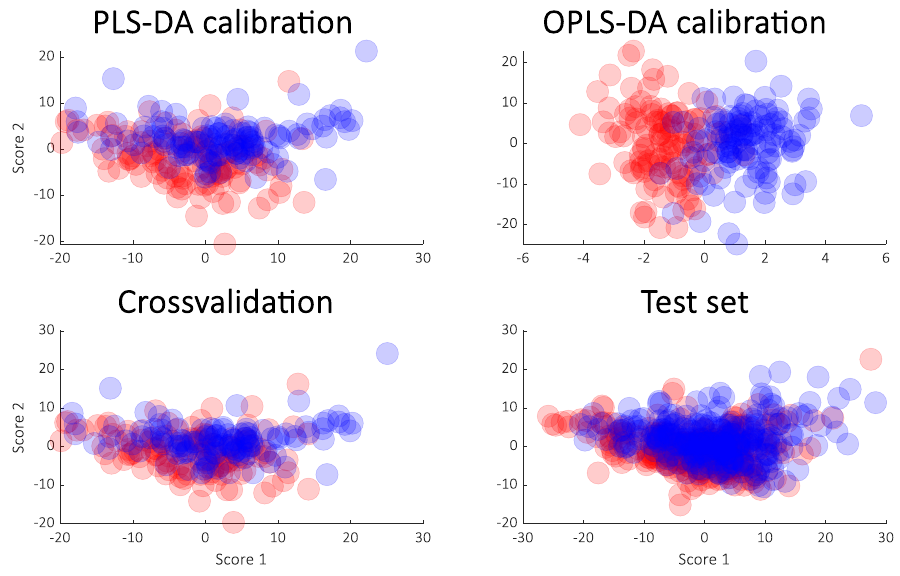
Figure 4. Score plot from PLS-DA (upper left) and OPLS-DA (upper right) from the cancer data. The cross-validated scores (lower left) and the score plot obtained from the test samples (lower right) are also shown.